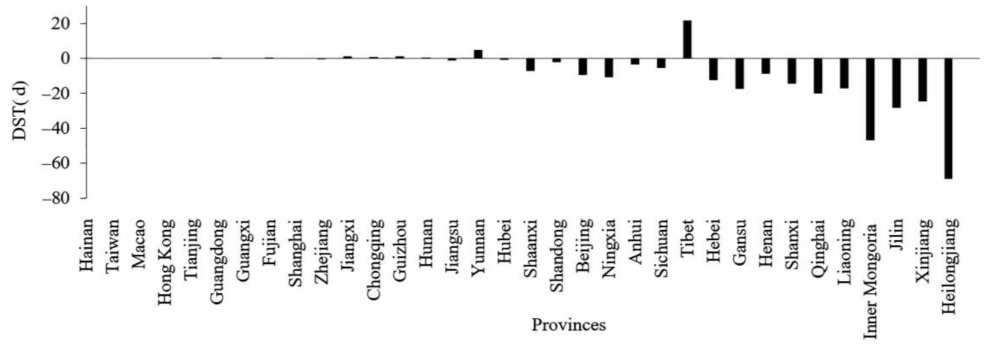
Figure 13. Difference in snowfall (DS) between the snow depth data from the GFDL-ESM2G model and meteorological station observations for each province.